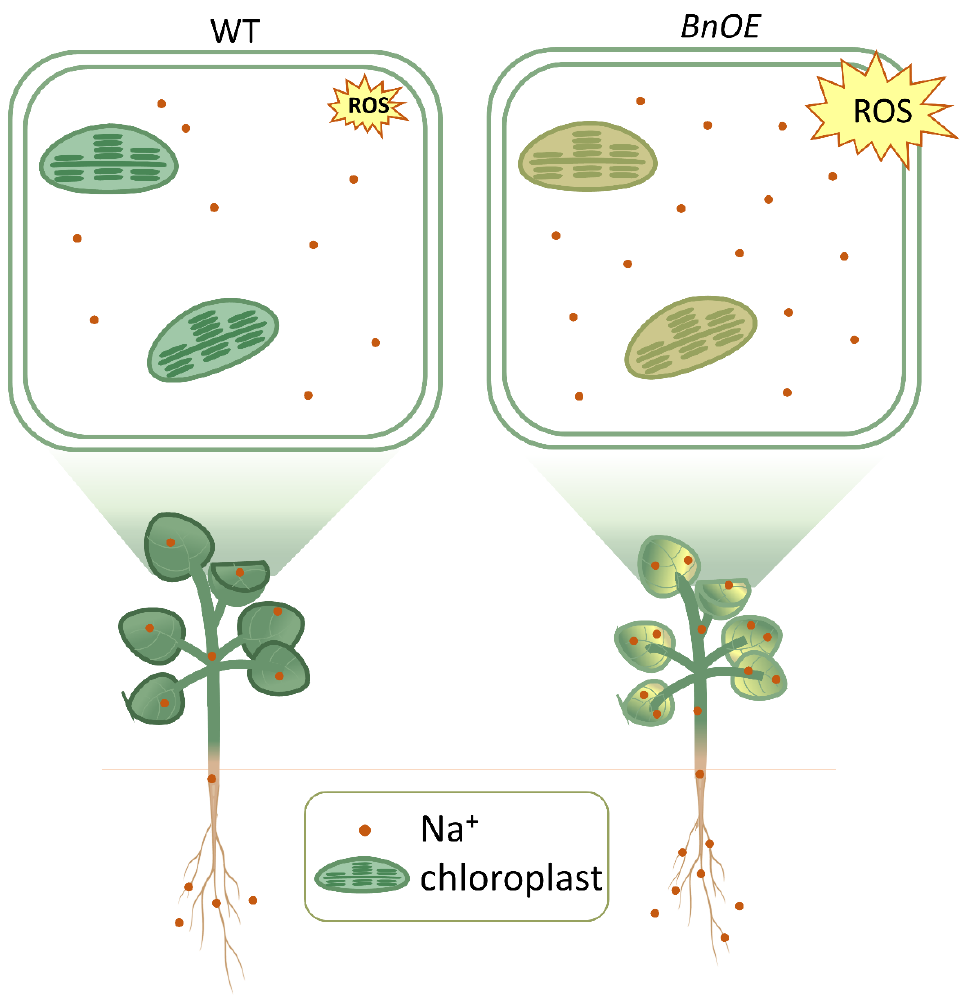
Figure 7. Overview of salt stress responses of WT and BnOE Brassica plants. ROS: reactive oxygen species.